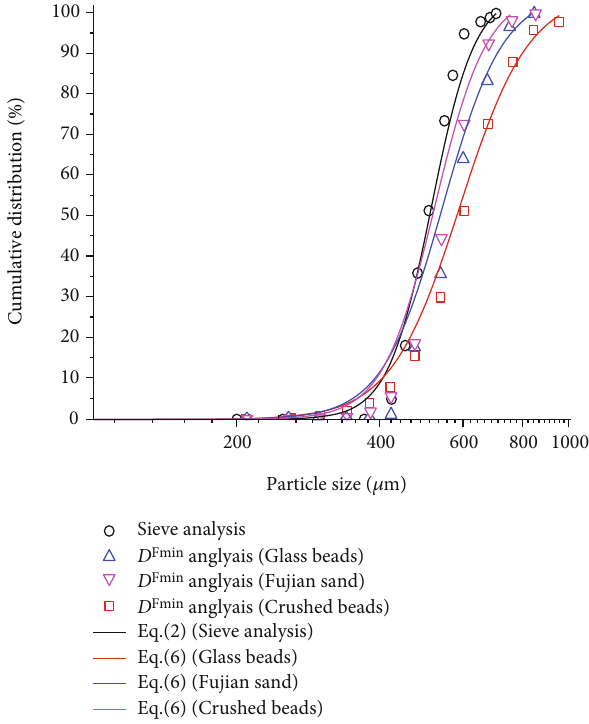
Figure 11: Validation for three di ff erent particles. Table 5: Shape indices and calculated